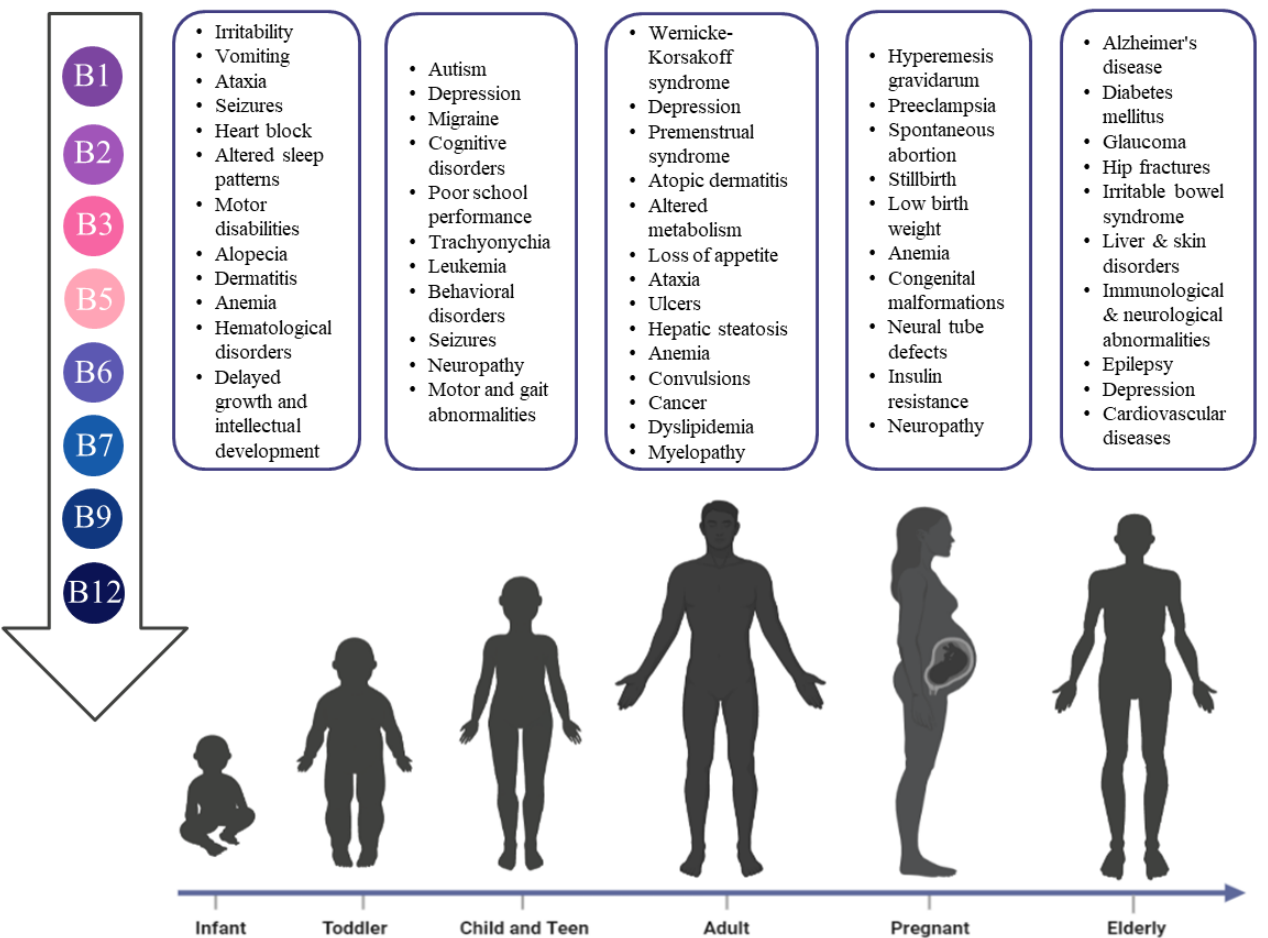
Figure 2. The risks of B vitamins deficiency in different life stages .